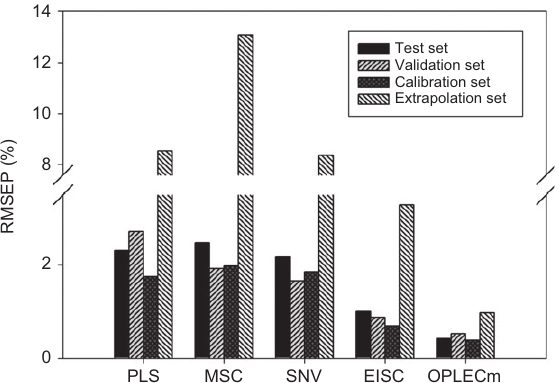
Figure 4 The RMSEP values for tecator data obtained by different calibration methods. (Reprinted with permission from J.W. Jin et al. Anal. Chem. 2012 , 84 , 320 – 326. Copyright 2006 American Chemical